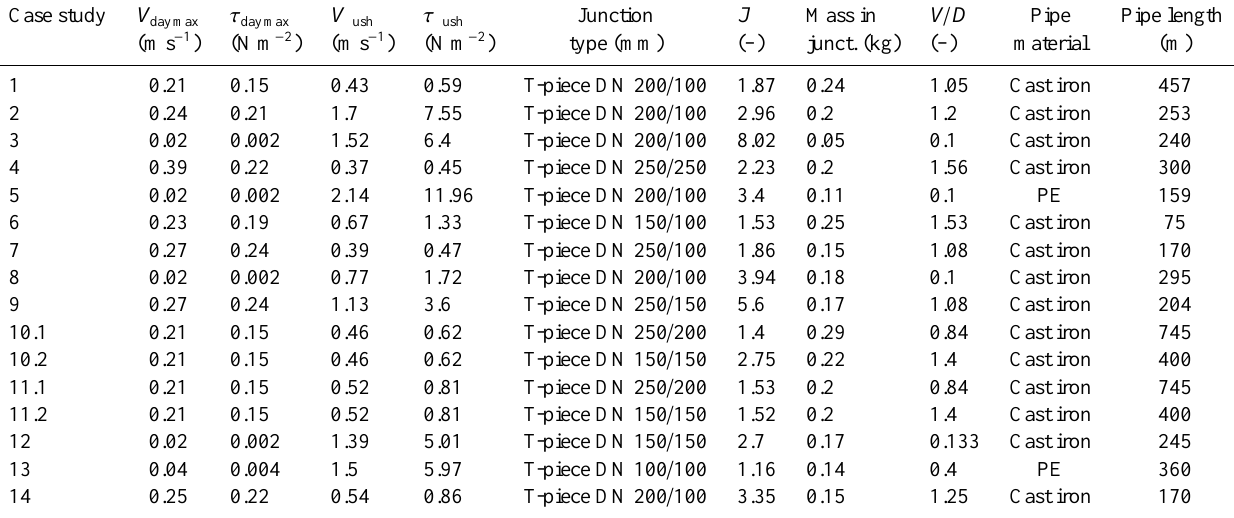
Table 3. Description of